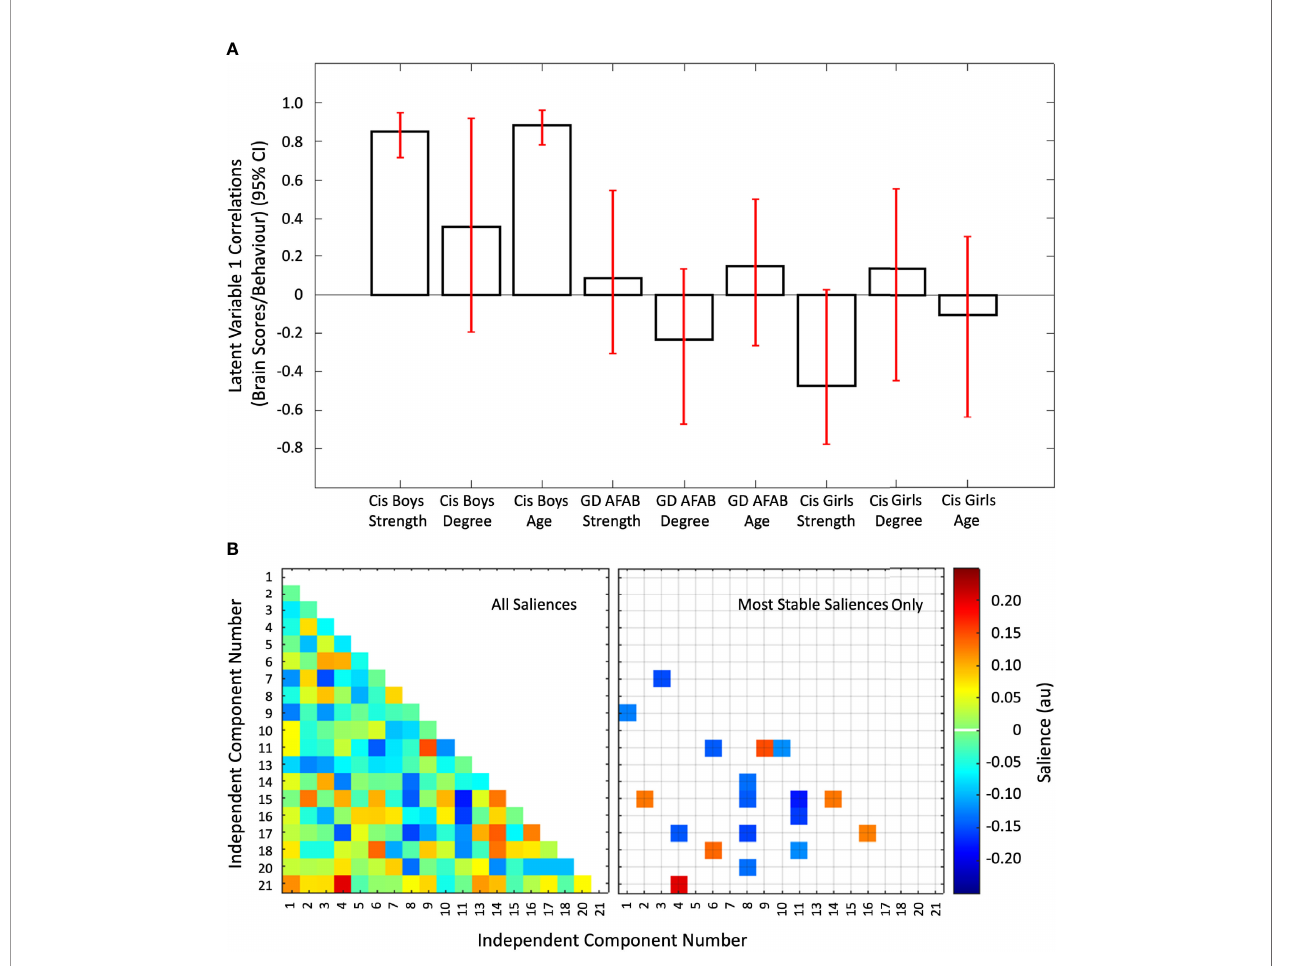
FIGURE 4 | The fi rst latent variable re fl ecting correlations of inter-network functional connectivity with age, strength of sexual attractions, and degree of sexual attractions. Panel (A) Cis = cisgender, Strength = strength of sexual attractions, Degree = degree of androphilia-gynephilia. Correlations of brain scores with behavior (± 95% con fi dence interval, CI) from the fi rst signi fi cant latent variable in the second PLS analysis. This latent variable identi fi ed stable correlations in cisgender boys related to age and strength of sexual attractions. No correlations were stable in the cisgender girls or GD AFAB (gender dysphoria, assigned female at birth) adolescents. Scatterplots of brain scores by behavioral measures for all participants can be found in Figure S2 ( Supplementary Material ). Panel (B) Heat maps of the brain saliences (left) and stable saliences (right) for 19 independent component (IC) pairs. This latent variable included stable positive and negative saliences in 18 IC pairs, shown on the right. ICs 12, 19, and 22-25 were discarded as noise or non-gray matter signal. Network names are in Table 1